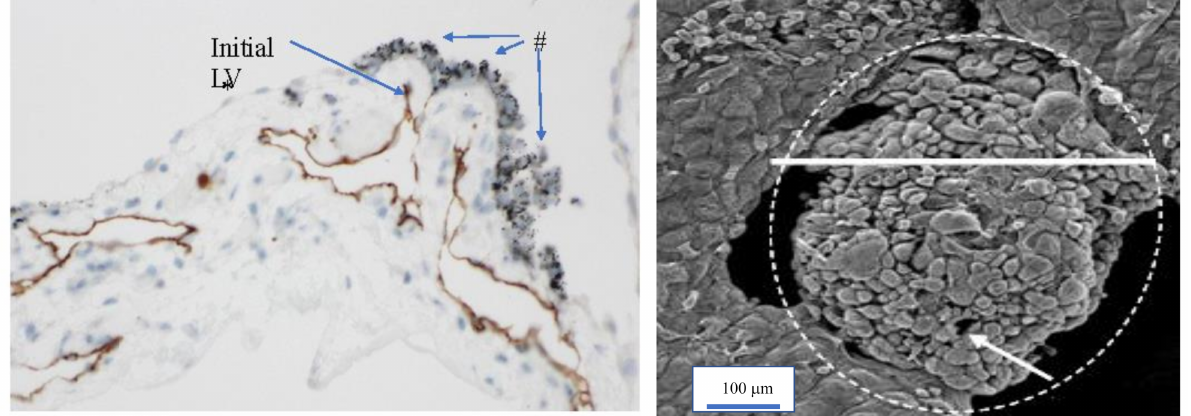
Figure 12. Histological features of human OMS stained with D2-40 antibody. The surface of the OMS is covered with cuboidal mesothelial cells. Macrophages (#) engulfing CH44 are located between the cuboidal mesothelial cells. Cuboidal mesothelial cells are surrounded by flat mesothelial cells (*) ( left ). The OMS activated by peritoneal carcinomatosis appear elevated due to the accumulation of macrophages on the surface ( right ).An arrow shows stoma connecting to holes in the MC and initial lymphatic vessels ( right